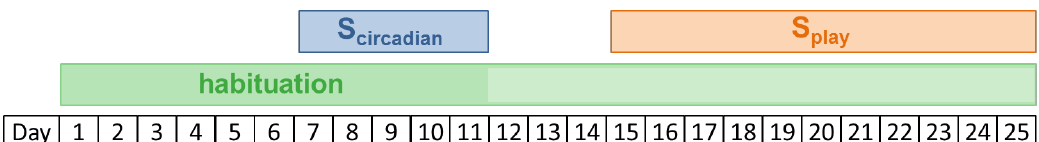
Figure 1. Schematic view of experimental phases. After the first days of habituation, saliva was sampled for detecting a circadian rhythm (S circadian ) on two consecutive days for each calf (between day 7 and day 11). Saliva sampling before and after play (S play ) took place on days 15 to 25. During the first 11 days, the habituation procedures were performed daily (dark green). To maintain familiarity of the calves with the experimenters, habituation was continued after S circadian on every second day (light green).